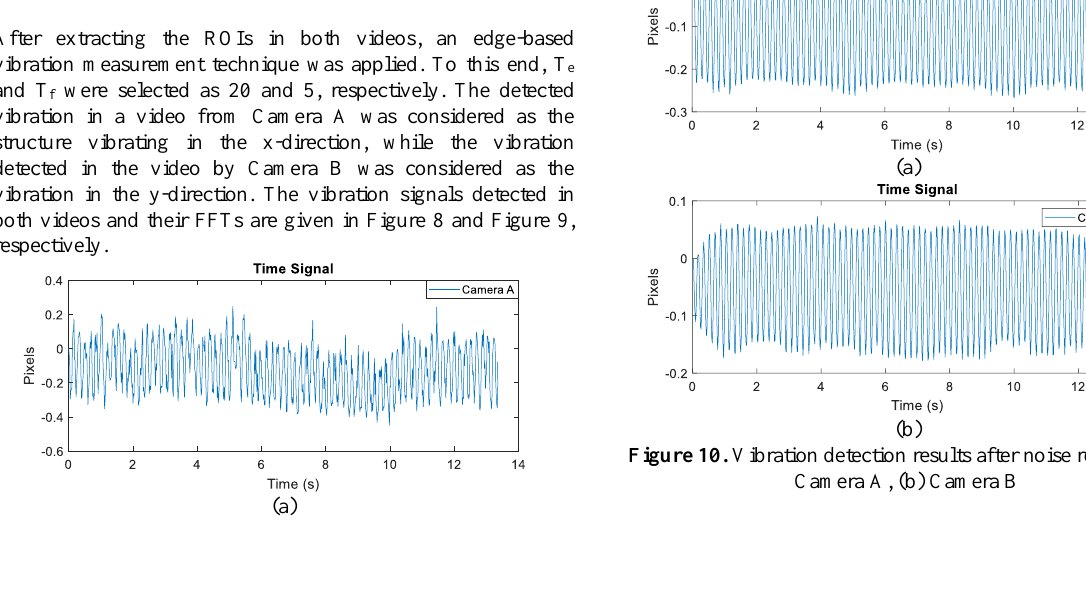
Figure 7. Epipolar line-based corresponding point selection: (a) Camera A, (b) Camera B